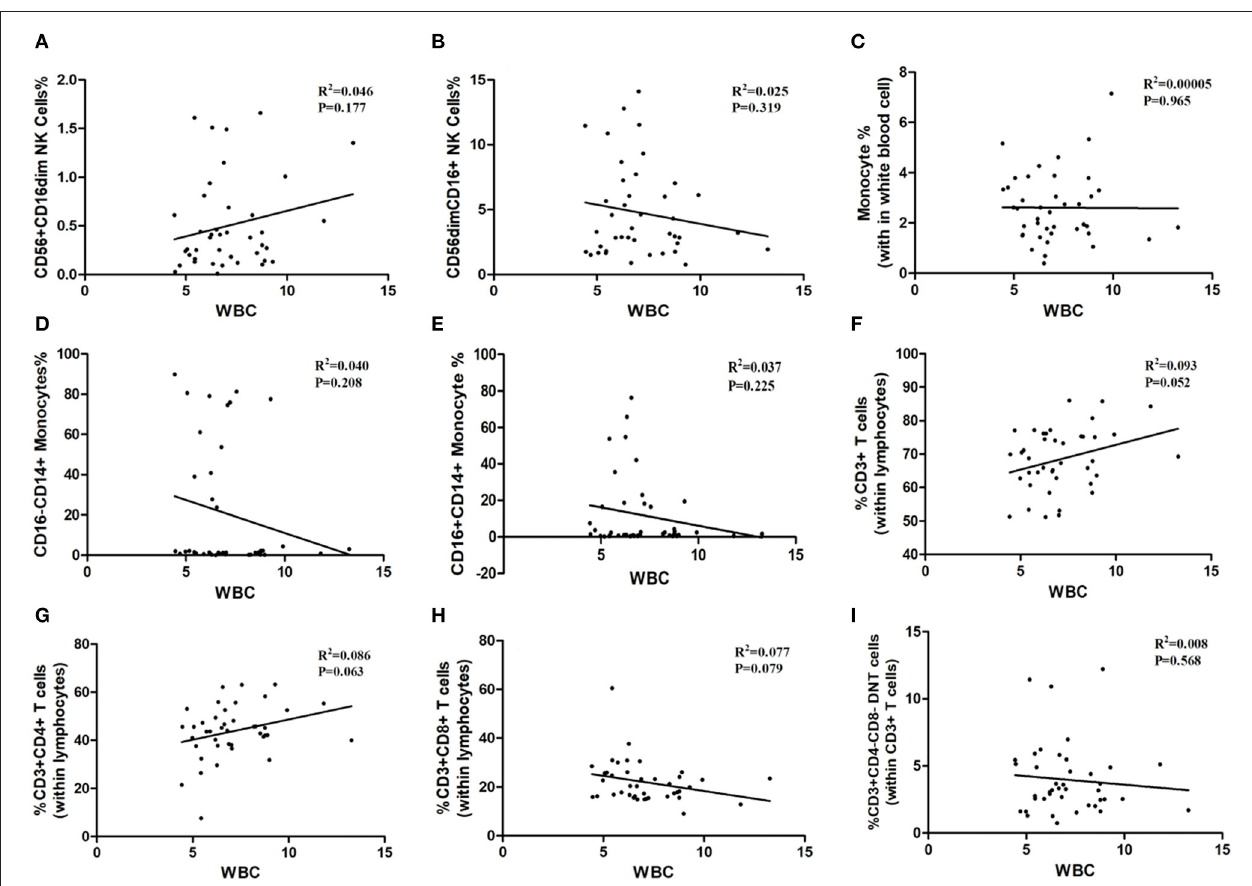
FIGURE 6 | The correlation between immune cells and white blood cell. WBC: white blood cell. (A) CD56 + CD16dim NK cells. (B) CD56 dim CD16 + NK cells. (C) Monocytes. (D) CD16 − CD14 + Monocytes. (E) CD16 + CD14 + Monocytes. (F) CD3 + T-Cells. (G) CD3 + CD4 + T-Cells. (H) CD3 + CD8 + T-Cells. (I) CD3 + CD4 − CD8 − T